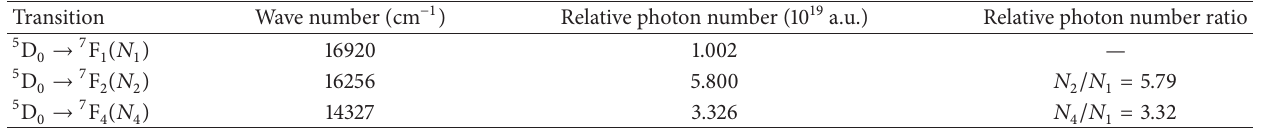
Table 1: Relative photon numbers and number ratios in EBA incorporated PMMA.